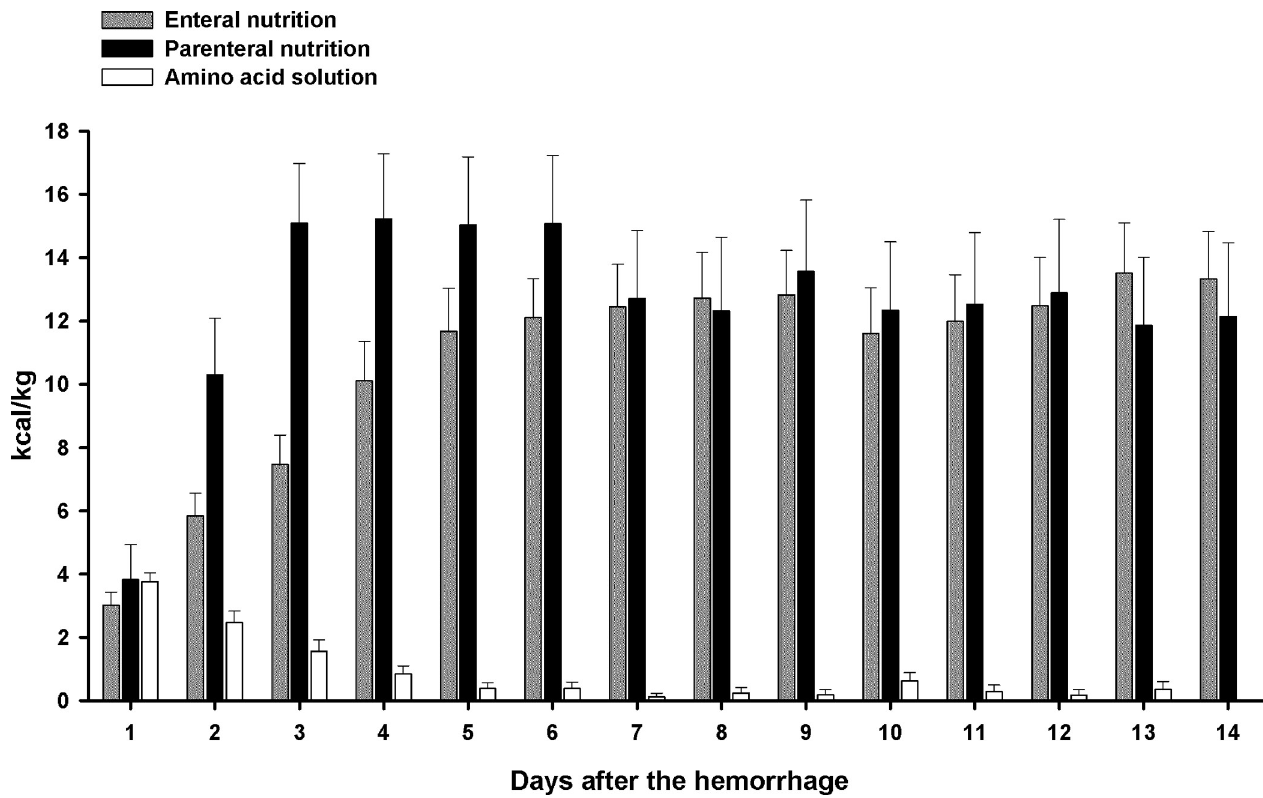
Fig 1. Fraction of provided calories by source. Daily mean kilocalories (kcal) per kilogram (kg) bodyweight provided by enteral nutrition, intravenous amino acid solutions (non-lipid-containing) and parenteral nutrition (lipid-containing) in 40 patients over 14 days following subarachnoid hemorrhage; error bars represent the standard error of mean.